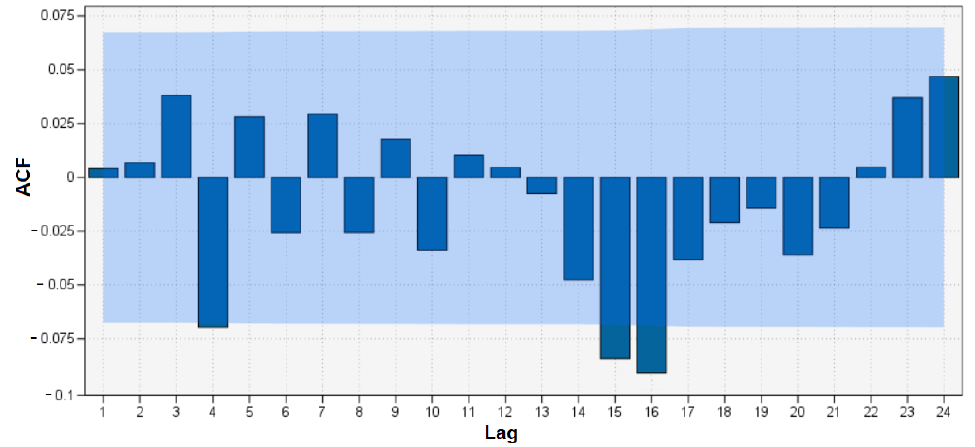
Figure 5. Example of an ACF plot.